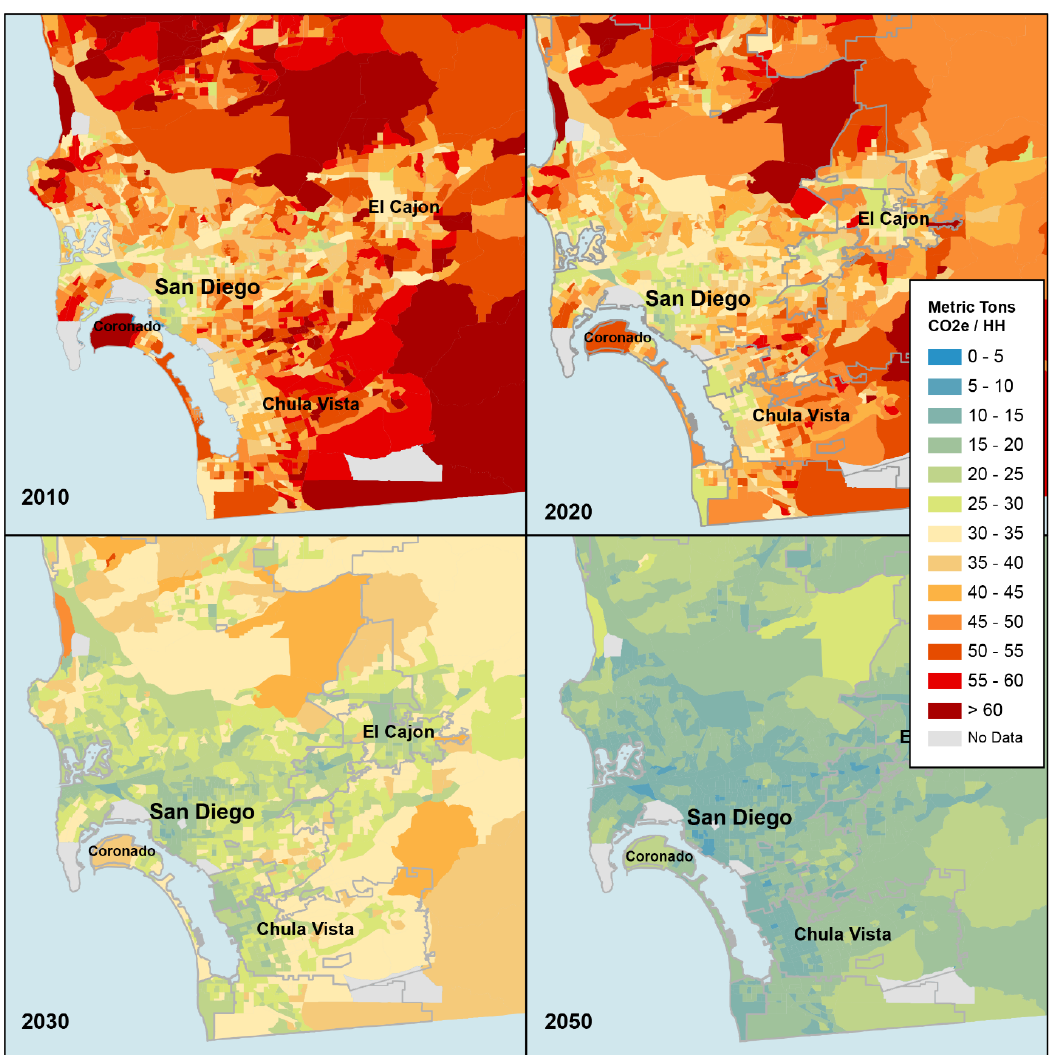
Figure 6. Average household carbon footprints of San Diego County neighborhoods under CA climate